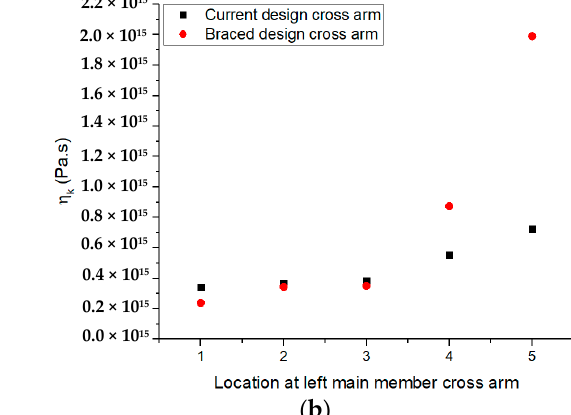
Figure 12. η k parameter for current and braced wooden cross-arms: ( a ) right; ( b ) left main members.